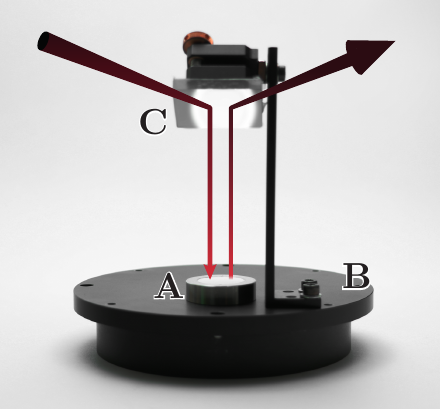
Figure 4. Metallic sample holder ring (A) containing the powder that is placed onto a base plate (B). A mirror (C) reflecting the excitation beam downwards and the emission beam sideways is located above the